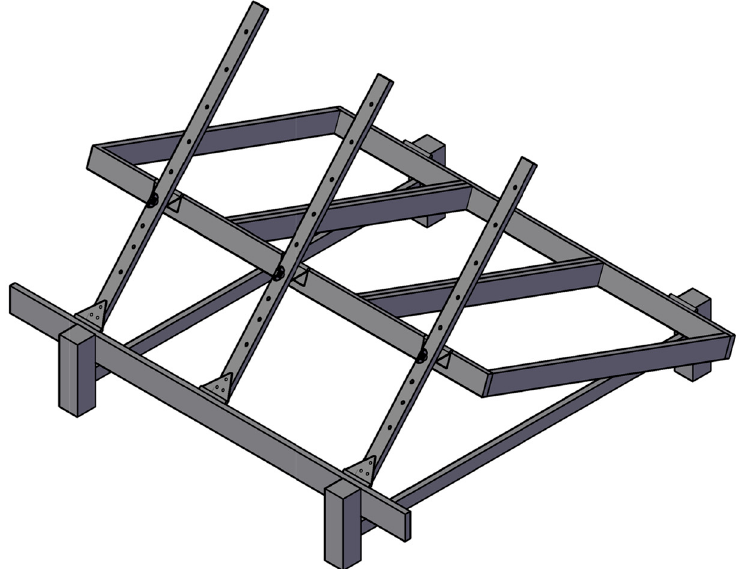
Figure 5. The spacing of 2 × 4 s on the system.